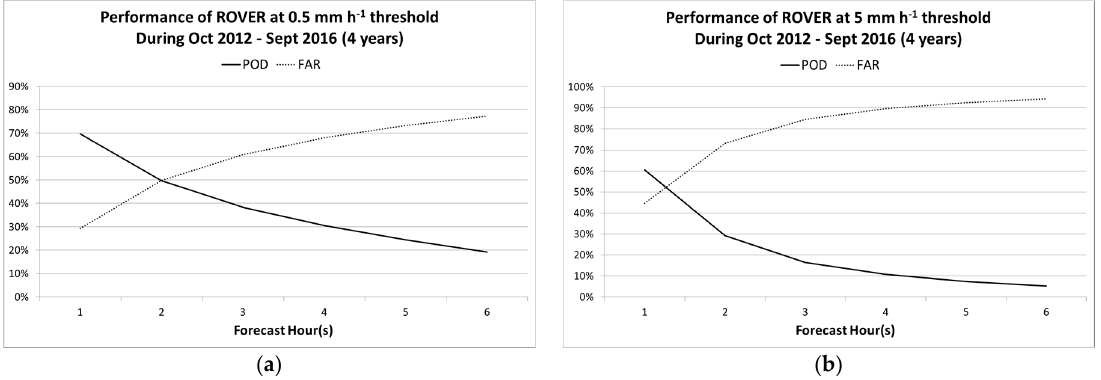
Figure 10. Across year comparison of the performance of ROVER at: ( a ) 0.5 mm·h − 1 ; and ( b ) 5 mm·h − 1 thresholds for forecast range of 1–6 h.